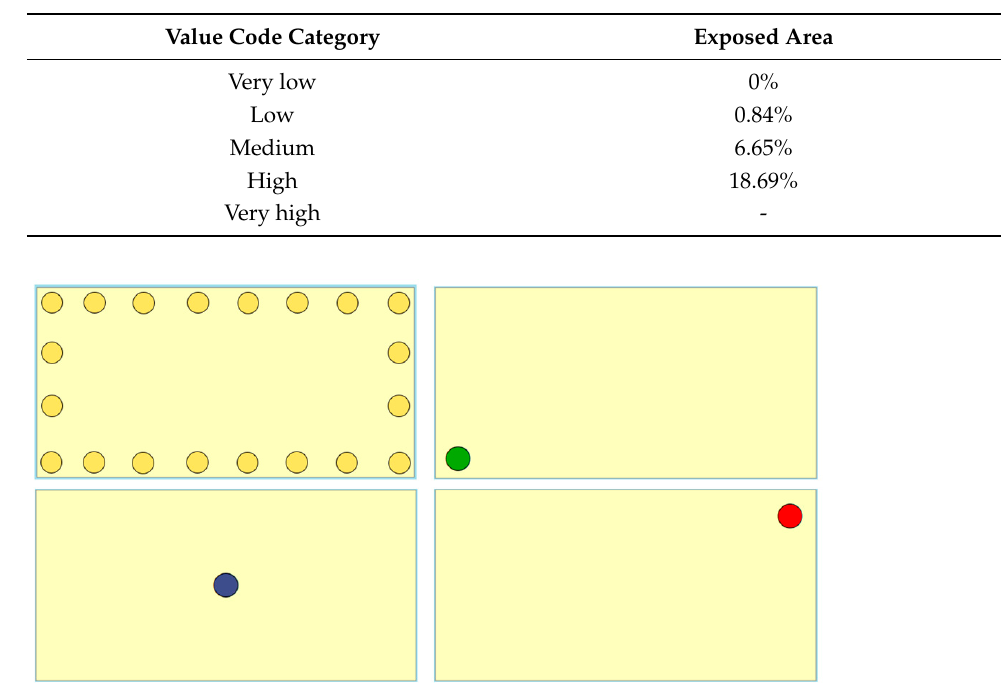
Table 4. Percentage of exposed area (MPA Southern North Sea) of interest as shown in Figure 4 and depending on value code category.